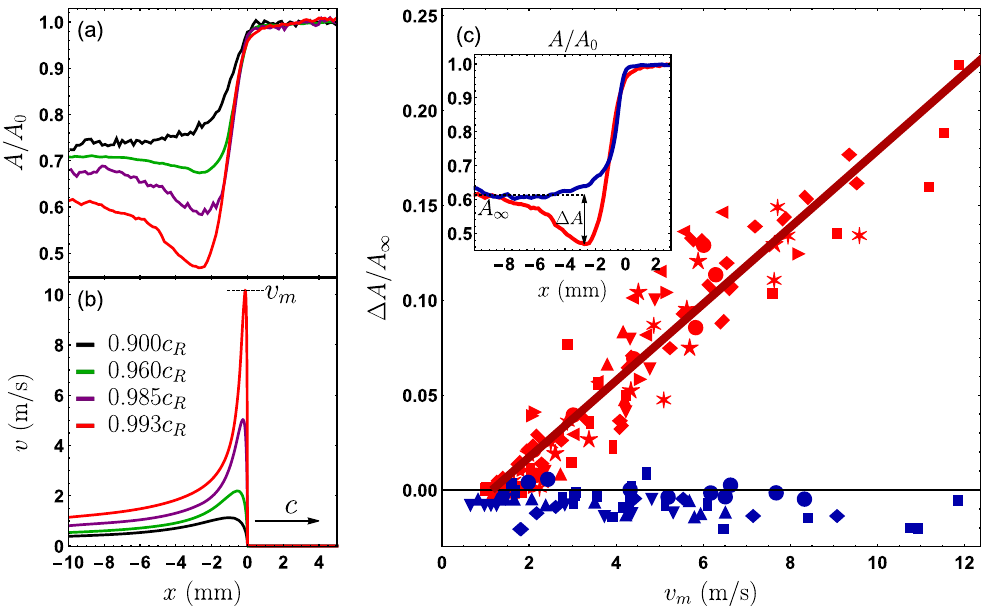
FIG. 2. Experimental results. (a) Snapshots of the spatial profile of the contact area A of rupture fronts in the “ thin-on-thick ” setup [see Fig. 1(a) and Ref. [49] for additional details]. These fronts propagate to the right at velocities c indicated in the legend of panel < c < 0 . 993 c (b) ( 0 . 900 c , see Ref. [57]), where x ¼ 0 corresponds to the tip of each rupture front. The contact area is normalized by R R its value A 0 before the passage of the front. (b) The slip-velocity profiles corresponding to the snapshots in panel (a) (see Ref. [57] for details). (c) Δ A=A ∞ , where Δ A is the magnitude of the real contact area undershoot and A ∞ is the asymptotic value (see inset) vs the maximal slip velocity v [see panel (b)] for both the thin-on-thick setup (red symbols) and the geometrically symmetric “ thin-on-thin ” m setup (blue symbols). Different symbols correspond to different experiments, and their size roughly corresponds to the measurement error. The red line is the best linear fit for the red symbols. (Inset) The contact area profile for c ¼ 0 . 993 c line, already appearing in panel (a)] and in the geometrically symmetric thin-on-thin setup (blue